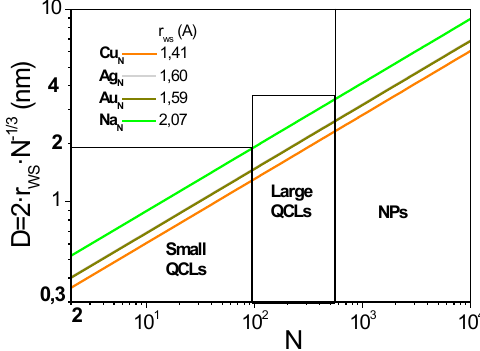
Figure 1. Classification scheme based on the size/number of atoms. QCL, quantum cluster.